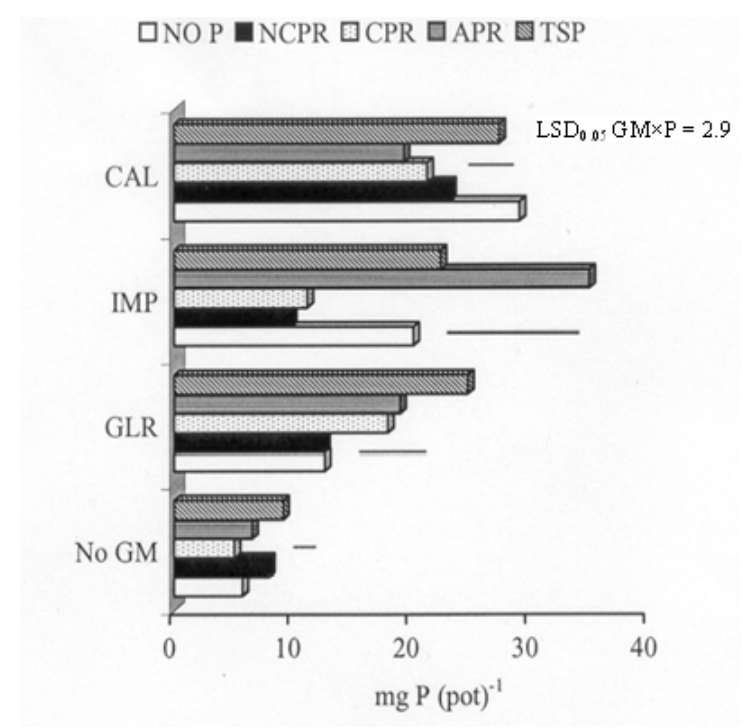
FIGURE 9. Total P uptake by Setaria sphacelata after 20 weeks growth in a tropical soil as affected by GMs and P fertilizers. Horizontal lines = LSD 0.05 .